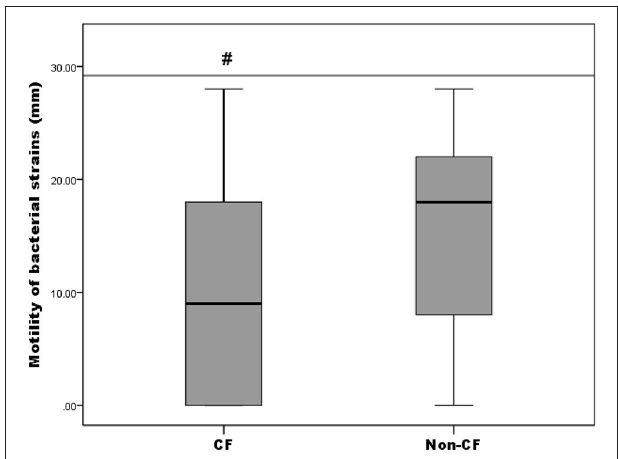
FIGURE 5 | Motility of CF isolates relative to non-CF isolates; # denotes statistical significance relative to non-CF